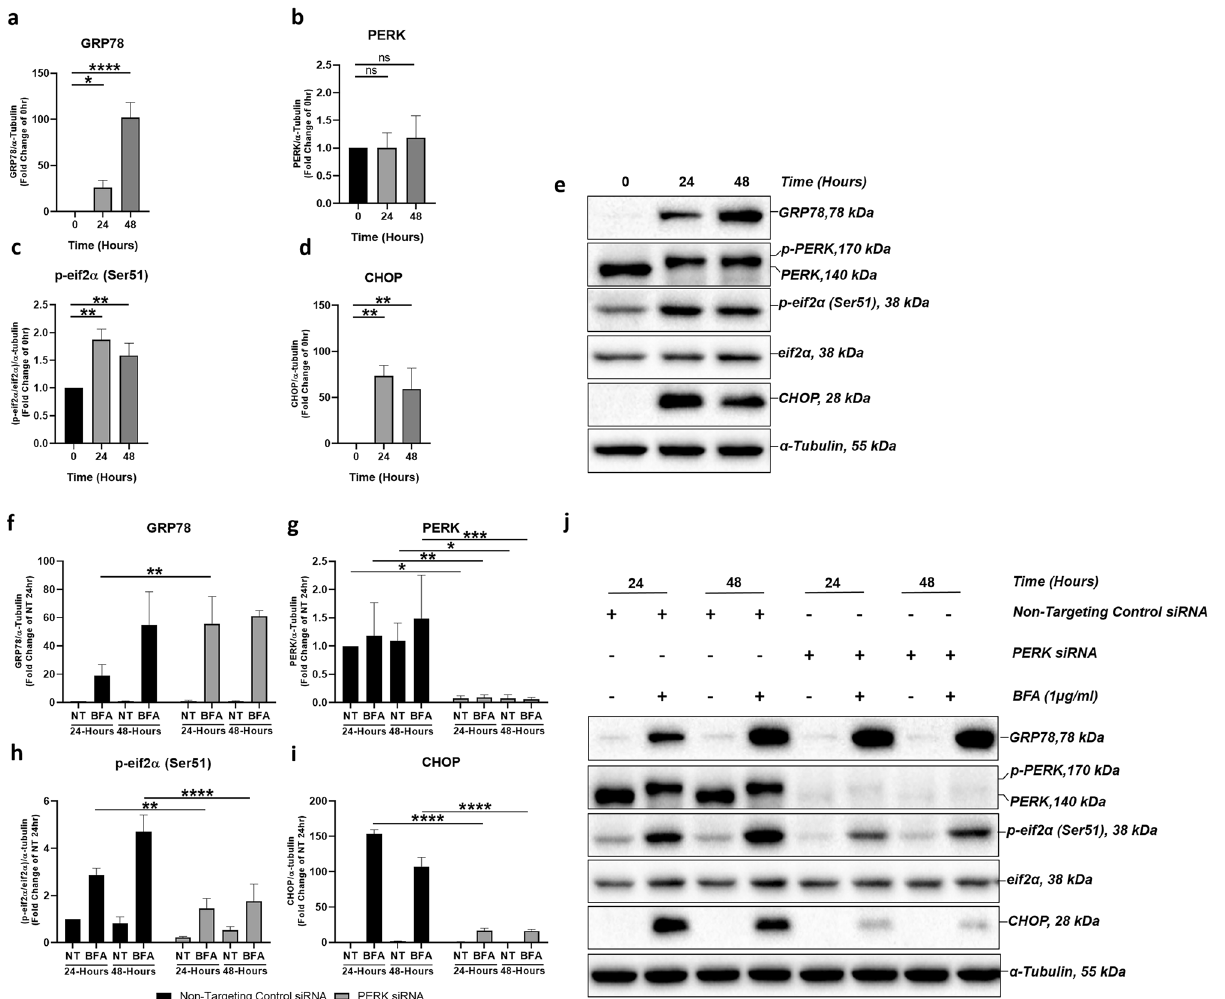
Figure 1. PERK downregulation increases ER stress. PERK signalling pathway mediates induction of ER stress in ARPE-19 cells treated with 1 μg/ml BFA through increased expression of GRP78 ( a ), PERK ( b ), p-eif2α (Ser51)/eif2α ( c ) and CHOP ( d ); representative immunoblots shown at 24-h and 48-h time-points ( e ). BFA- induced ER stress in cells in which PERK is downregulated with siRNA leads to significant upregulation of GRP78 ( f ) at 24-h time point and significant downregulation of PERK pathway components PERK ( g ), p-eif2α (Ser51)/eif2α ( h ) and CHOP ( i ) at 24 and 48-h time points when compared to non-targeting control siRNA; ( i ) representative immunoblots shown. Phosphorylation of PERK was observed from the slower migration of a total PERK band at 170 kDa following treatment with BFA ( b , g , e , j ). Phosphorylation of eif2α at serine 51 (p-eif2α (Ser 51)) was calculated relative to total eif2a protein expression ( c , h ). Results are presented as fold- changes of the 0-h time point ( a – d ) or the NT group in cells transfected with non-targeting control siRNA ( f – i ). Protein levels were normalised to α-tubulin. Means ± standard deviation are shown (n = 3). Statistical analysis was performed using a one-way ANOVA with Dunnet’s post-hoc test ( a – d ) or two-way ANOVA with Sidak’s multiple-comparison test ( f – i ) (* p ≤ 0.05, ** p ≤ 0.01, *** p ≤ 0.001, **** p ≤ 0.0001). BFA Brefeldin A, NT non- treated, NS